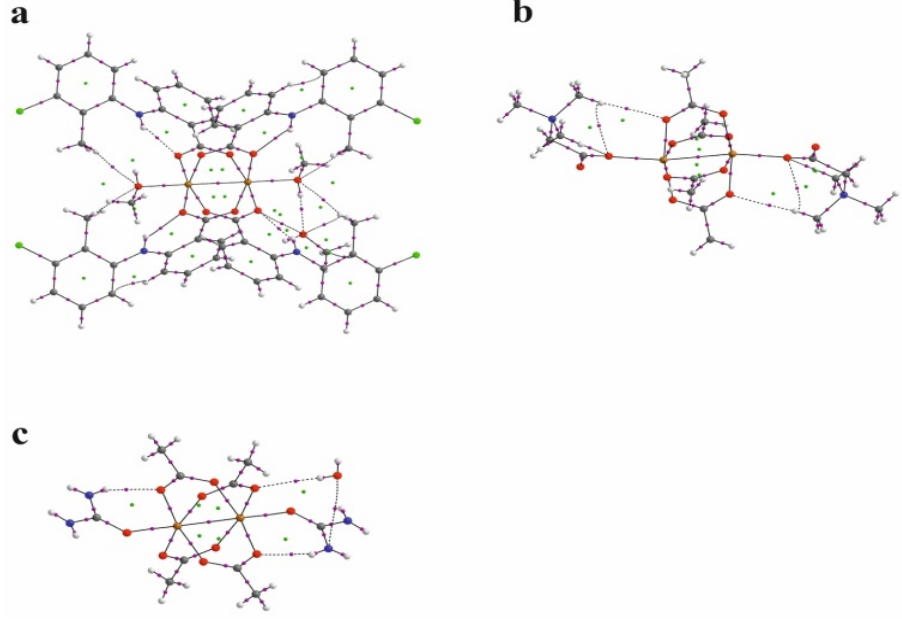
Figure 4. QTAIM diagrams for [Cu II2 (Tolf) 4 (MeOH) 2 ] ∙ 2MeOH ( a ), QEBQIX ( b ), and ACURCU01 ( c ). The lines connecting the nuclei are the bond paths. Red and yellow dots represent the BCPs and RCPs, respectively.